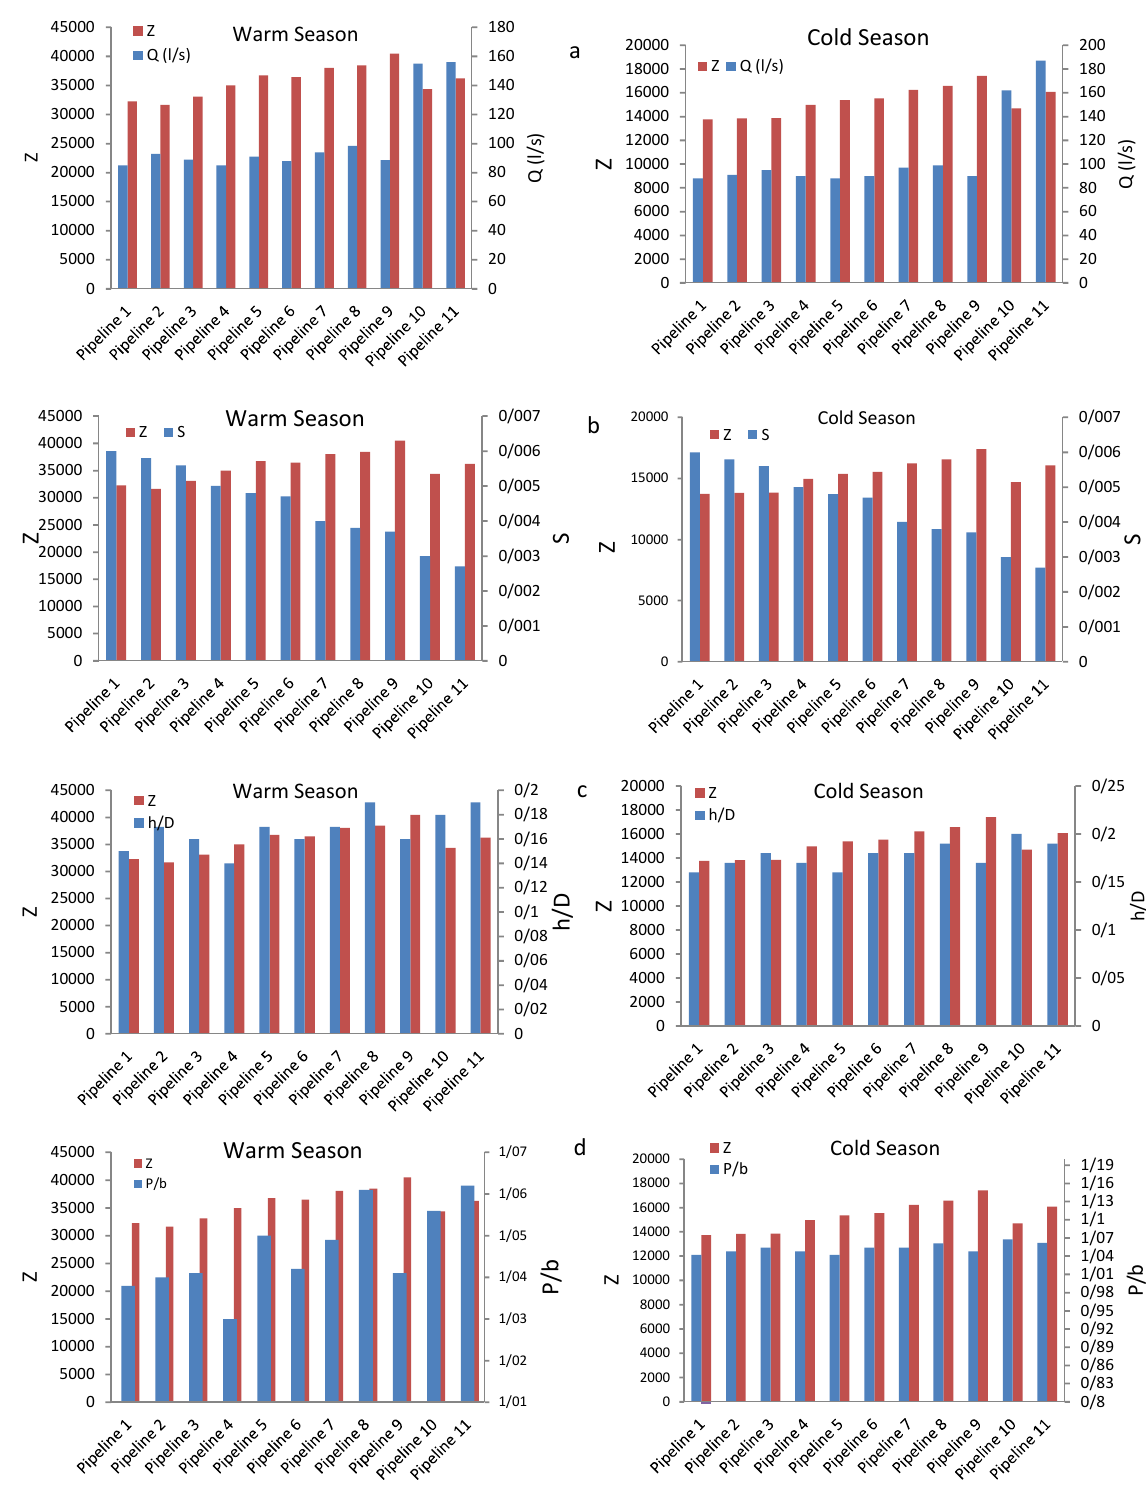
Fig. 2. Variations in Z Level Due to Changes in Several Parameters in Warm and Cold Seasons and Various Pipelines ( a: different Q [l/s], b: different S, c: different h/D, d: different